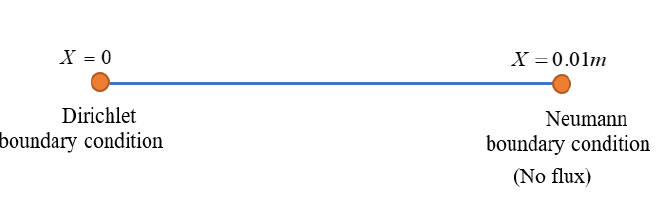
Figure A1. Configuration of benchmark